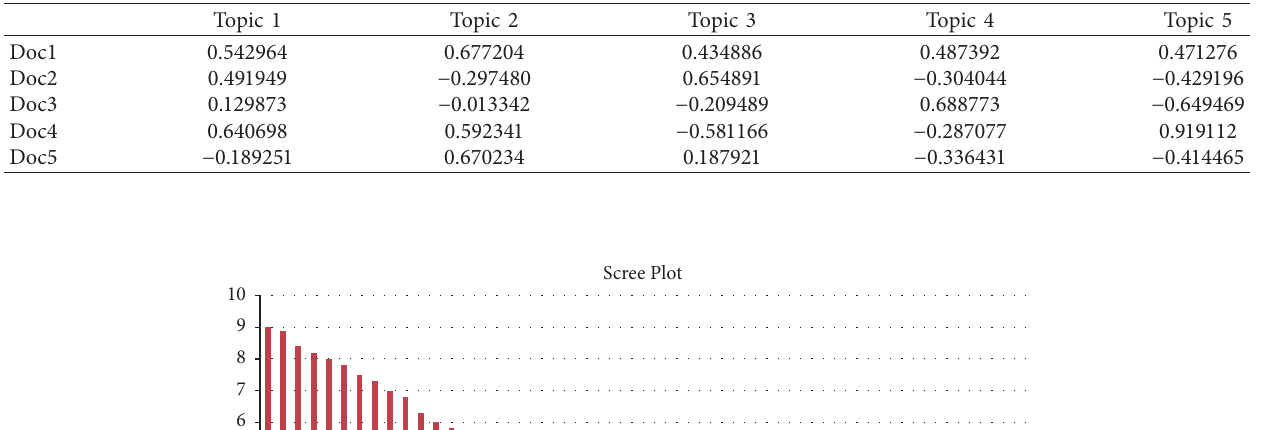
Table 8: Document loading with five latent topics.